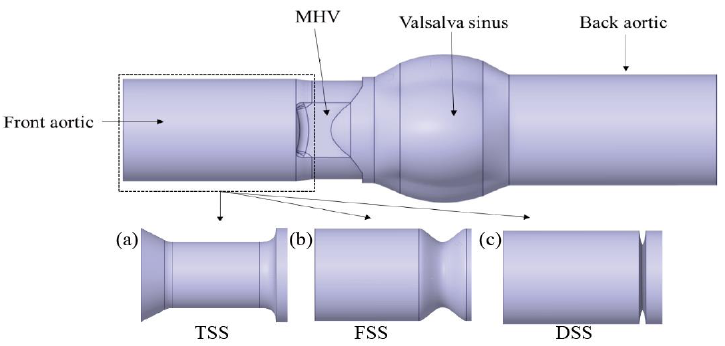
Figure 1. MHV structure and obstruction complications (( a ) TSS, ( b ) FSS, ( c ) DSS). TSS: tunnel-type SAS (long, narrow fibromuscular tracts). FSS: fibromuscular annulus SAS (thicker fibromuscular ridges). DSS: discrete SAS (described as 1–2 mm of semilunar valve-like fibromuscular mem- brane composition [19]).